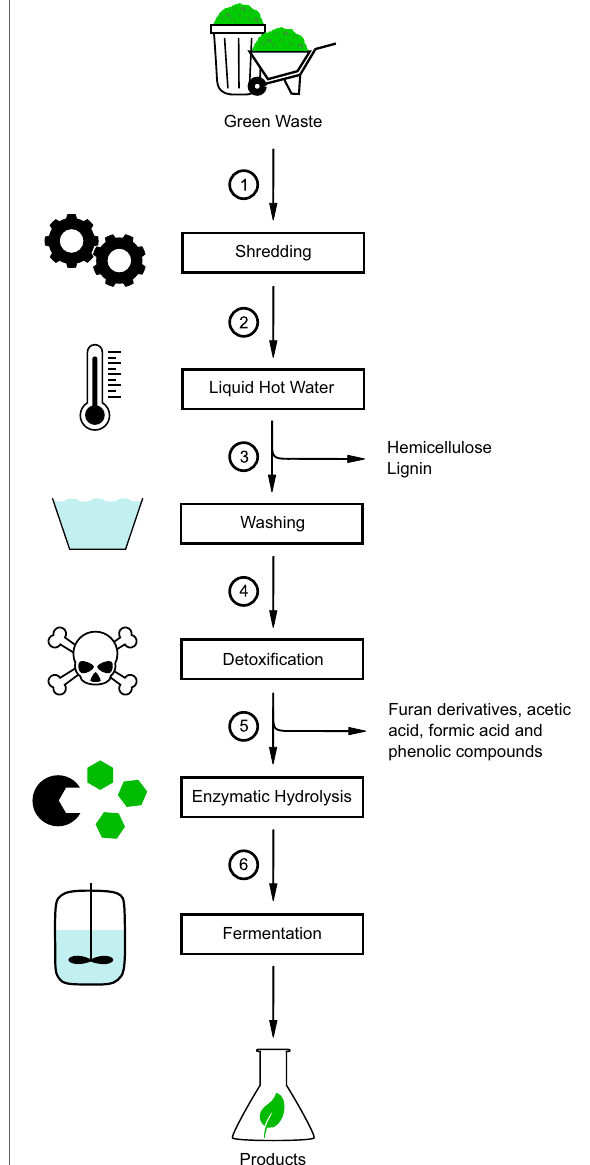
Fig. 2 Exemplary pretreatment process of green waste for fermentative utilization. Green waste is shredded (1) and pretreated using elevated temperature and pressure, removing hemicellulose and lignin (2). The resulting hydrolysate is washed (3) and detoxified, e.g., using activated carbon, to eliminate furan derivatives, acids, and phenolic compounds (4). The process is followed by an enzymatic hydrolysis to obtain monosaccharides (5), which are then used in microbial fermentations